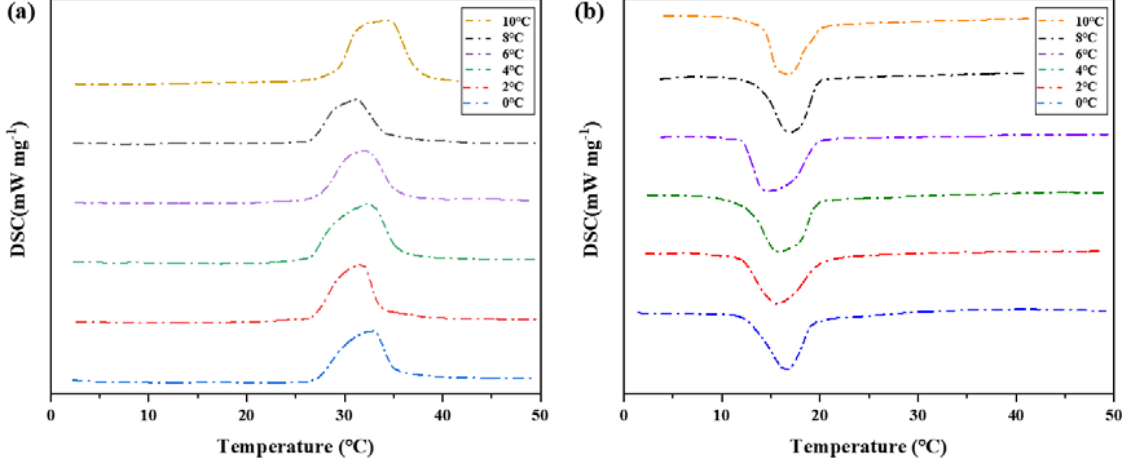
Figure 12. DSC characterization of phase transition properties of binary composite phase change materials at different cooling temperatures. ( a ) DSC curve of the second temperature rise. ( b ) Step cooling curve of the exothermic process. Table 4. Thermal performance parameters measured by DSC at different cooling